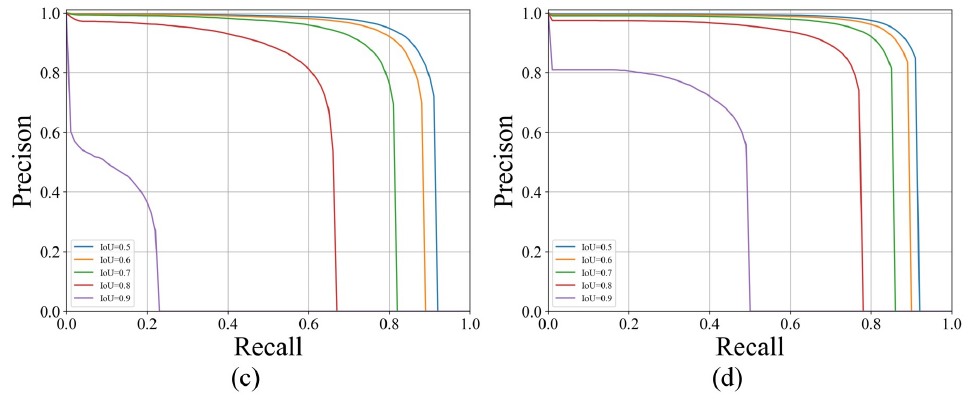
Figure 14. Precision-recall curve with different IoU thresholds: ( a ) Mask R-CNN, ( b ) Hybrid Task Cascade, ( c ) SOLOv2, ( d ) Proposed